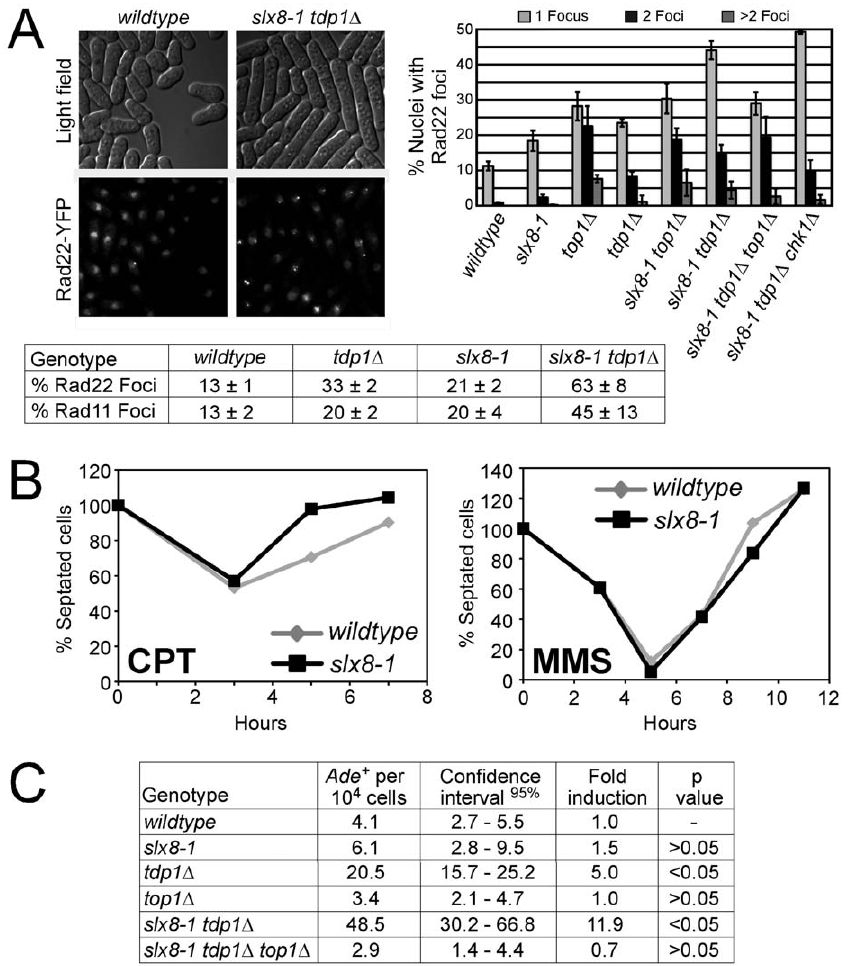
Figure 3. STUbL mutant tdp1 D cells exhibit elevated Top1-dependent DNA damage and spontaneous genomic instability. (A) Upper left: live cell images of the indicated strains expressing Rad22-YFP (Rad52). Upper right: graph depicting the percentage of nuclei containing one, two, or multiple Rad22-YFP foci using live-cell microscopy in the indicated genotypes. Error bars represent the standard deviations from three independent experiments. Base: Table depicting the percentage of nuclei containing one or more Rad22-YFP or Rad11-YFP (RPA) foci in the indicated genotypes. Standard deviations are derived from three independent experiments. (B) Log phase cultures of slx8-1 and wildtype cells were treated with 40 m M CPT or 0.008% MMS. G2 checkpoint arrest and recovery was monitored through determining the percentage of septated cells at the indicated times. (C) Table depicting frequency of spontaneous mitotic recombination between tandem adenine heteroalleles in the indicated strains. Rates represent the mean of the means, between at least three independent assays per strain. All experiments were incubated at 25 u